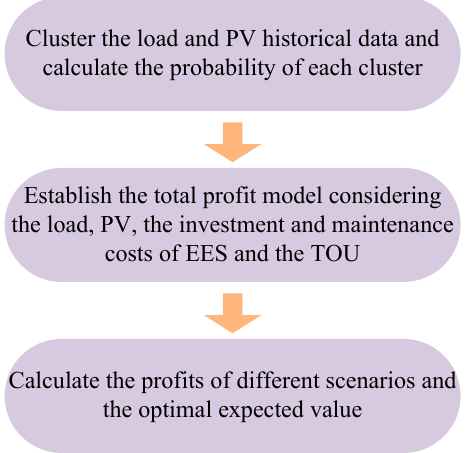
Figure 1. The overall architecture of the expected value model.